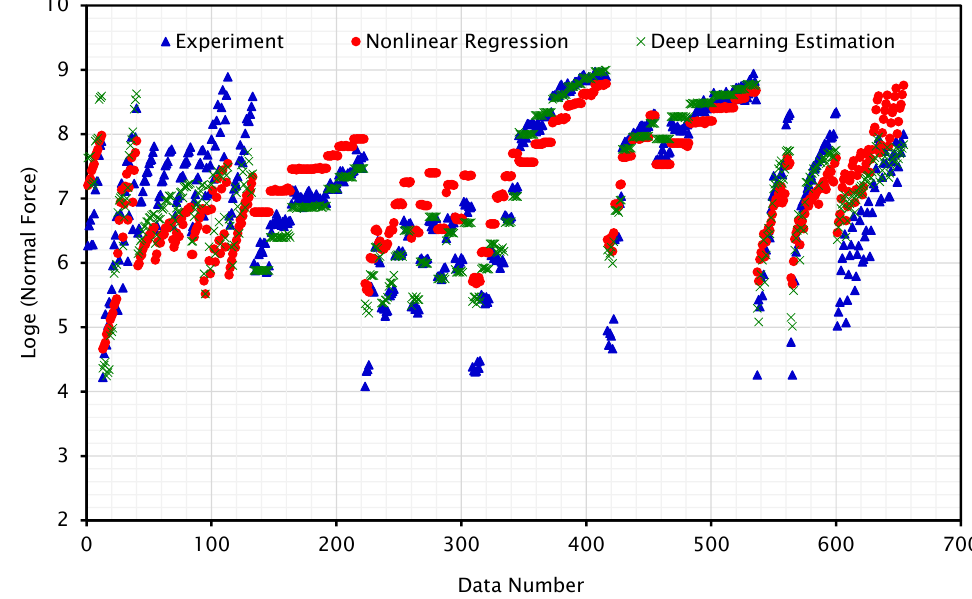
Figure 11. Scatter plot of experimental data and the calculated values by the regression methods for normal